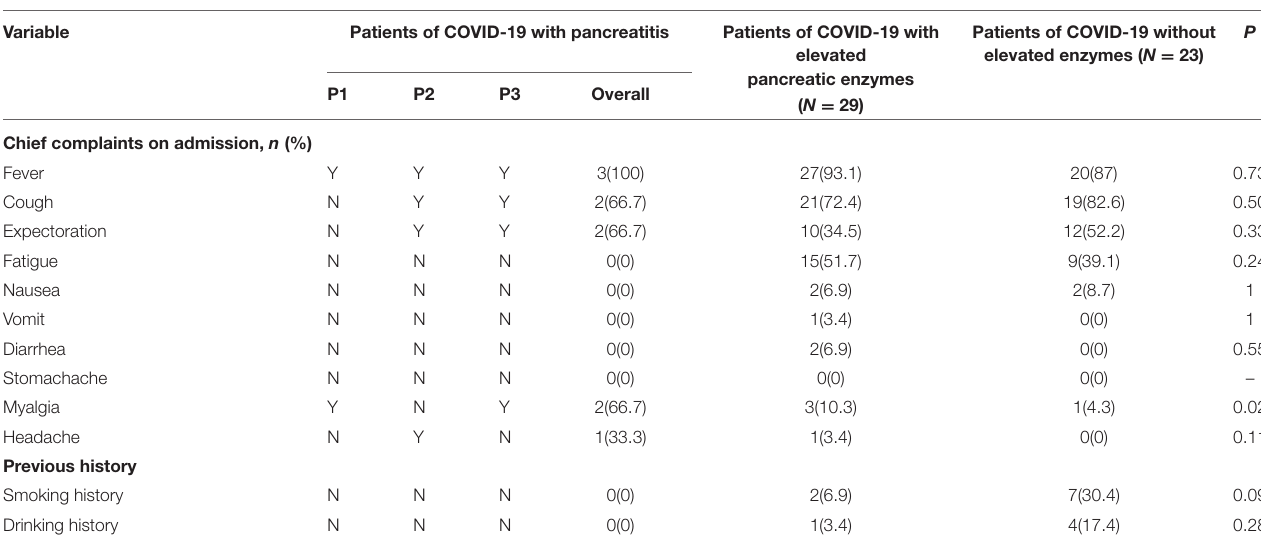
TABLE 2 | Chief complaints of patients with COVID-19. Variable Patients of COVID-19 with